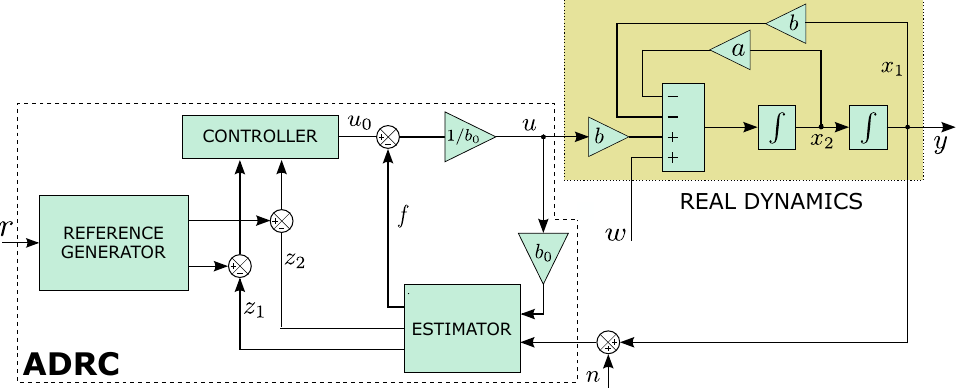
Figure 6. ADRC block diagram of a generic second order plant.